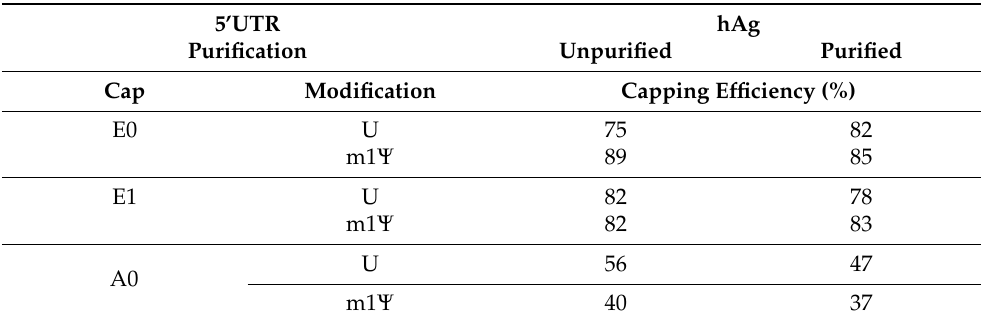
Table 5. Quantification of capping efficiencies of IVT mRNAs after the RNase H cleavage assay and visualization using 21% PAGE, 8 M urea. 5’UTR hAg Purification Unpurified Purified Cap Modification Capping Efficiency